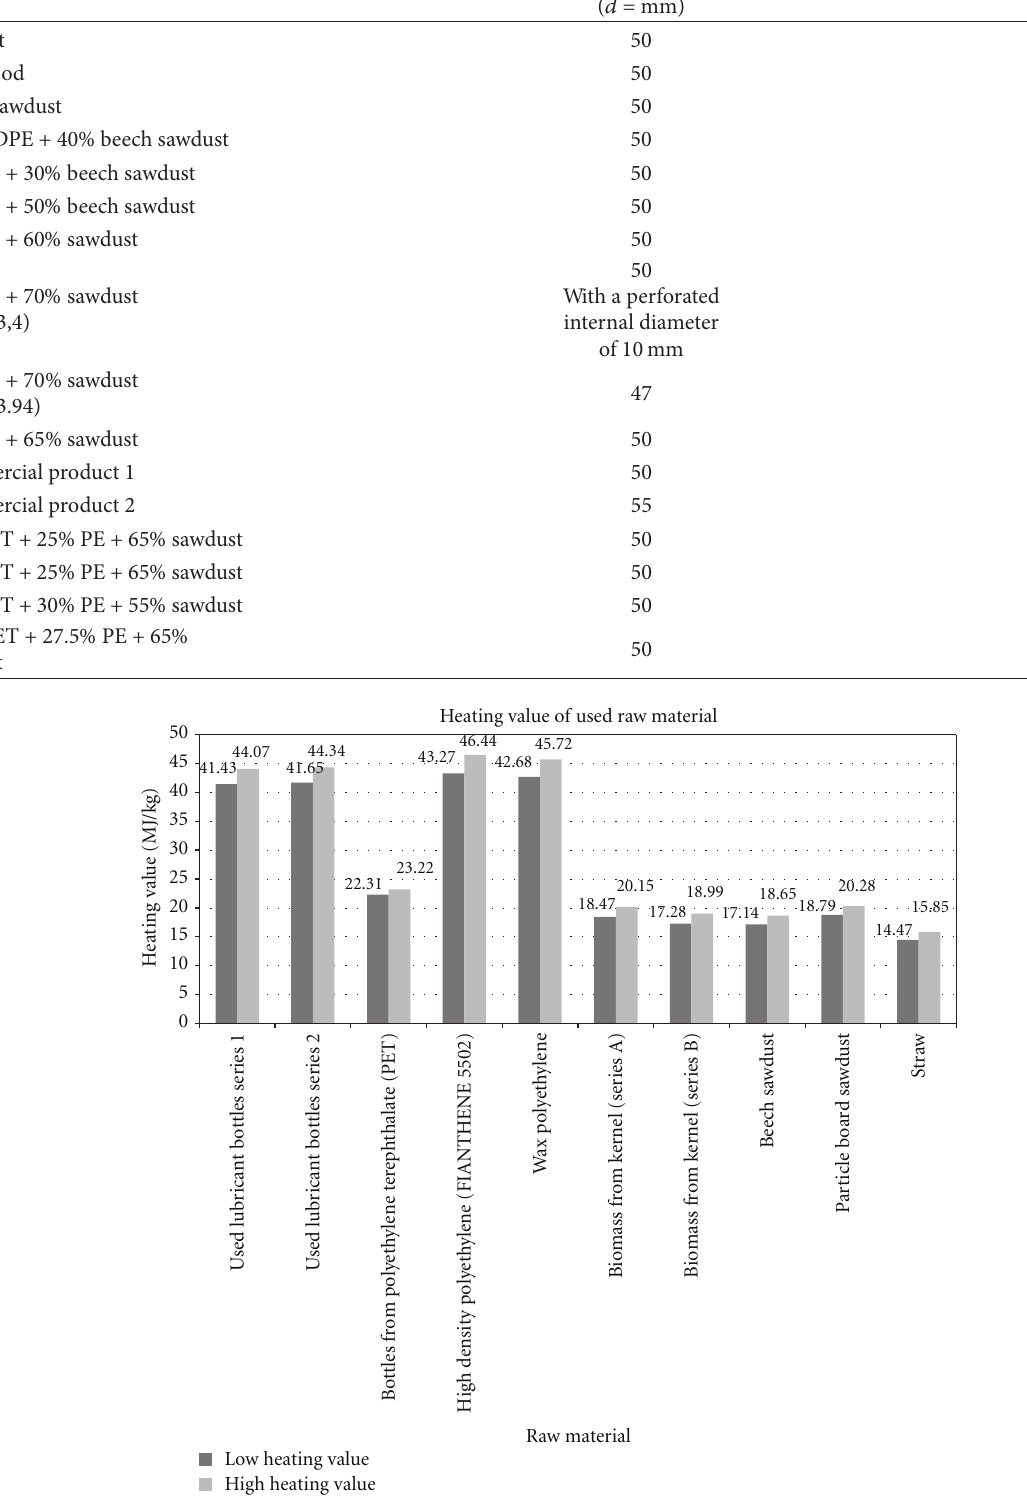
F 2: High and low heating value of the selected raw